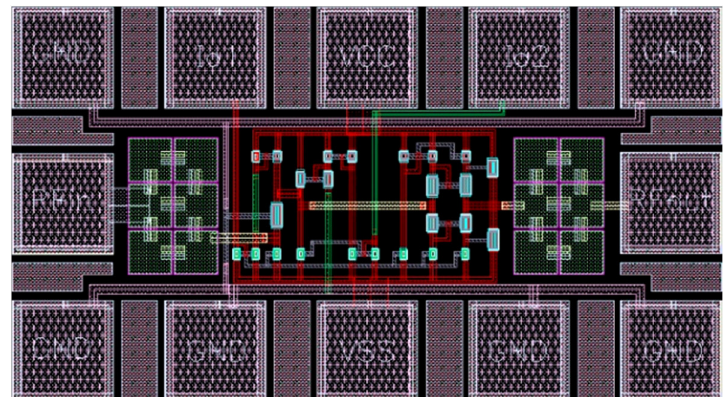
Figure 4. The layout diagram of the proposed wideband LNA.